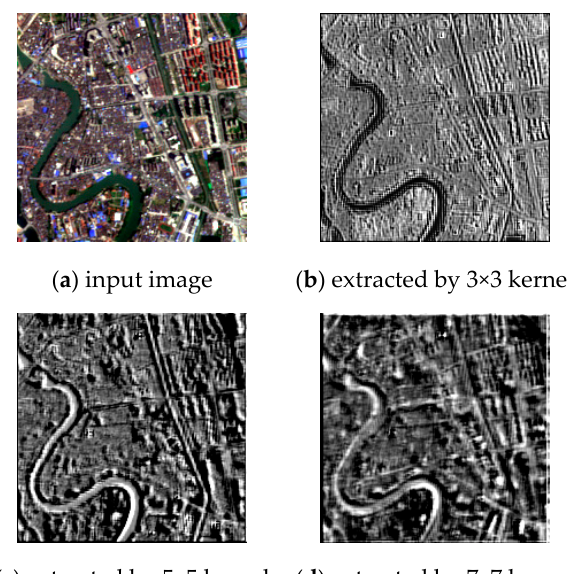
Figure 2. The feature maps extracted by the multiple-scale convolution kernels.